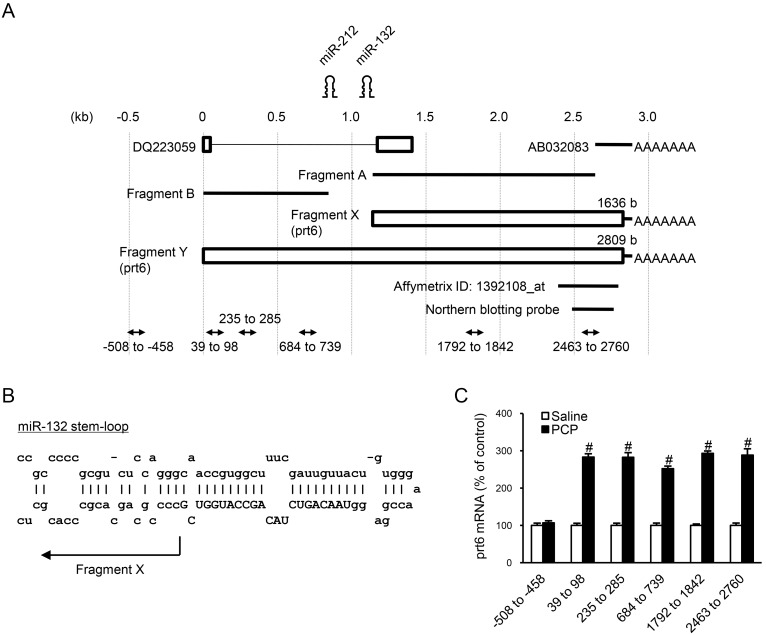
Cloning and expression of rat prt6.(A) Structures of prt6 cDNAs. The schematic presentation of prt6 transcripts is illustrated based on the data obtained by RACE-PCR and database analyses. The two prt6 transcripts of 1636 bases (Fragment X) and 2809 bases (Fragment Y), shown as open boxes, correspond to the lower and upper bands detected by Northern blot, respectively. Bold lines of Fragments A and B indicate positions of the cDNA fragments detected by 5′-RACE-PCR. (B) The 5′ end of Fragment X is located exactly adjacent to the 3′ end of preRNA for miR-132. Capital letters indicate the nucleotide sequences of mature miR-132. (C) Expression levels of the various parts of the putative prt6 RNA 60 min after acute PCP administration were determined by RT-PCR with the primer sets for amplification of the respective parts indicated in Figure 2A. Results are the means with S.E.M. of data (the individual ratios of expressional levels of prt6 to those of GAPDH (prt6/GAPDH)) obtained from 8 rats per group: −508 to −458, saline 100±6% (prt6/GAPDH: 0.859±0.052), PCP 107±6%, p>0.05 vs saline-treated controls; 39 to 98, saline 100±6% (prt6/GAPDH: 0.591±0.010), PCP 283±9%#, #p<0.01 vs saline-treated controls; 235 to 285, saline 100±6% (prt6/GAPDH: 0.576±0.034), PCP 283±13%#, #p<0.01 vs saline-treated controls; 684 to 739, saline 100±6% (prt6/GAPDH: 0.634±0.040), PCP 252±7%#, #p<0.01 vs saline-treated controls; 1792 to 1842, saline 100±4% (prt6/GAPDH: 0.515±0.020), PCP 293±6%#, #p<0.01 vs saline-treated controls; 2436 to 2760, saline 100±6% (prt6/GAPDH: 0.527±0.033), PCP 289±16%#, #p<0.01 vs saline-treated controls. #P<0.01 vs. respective saline-treated controls.